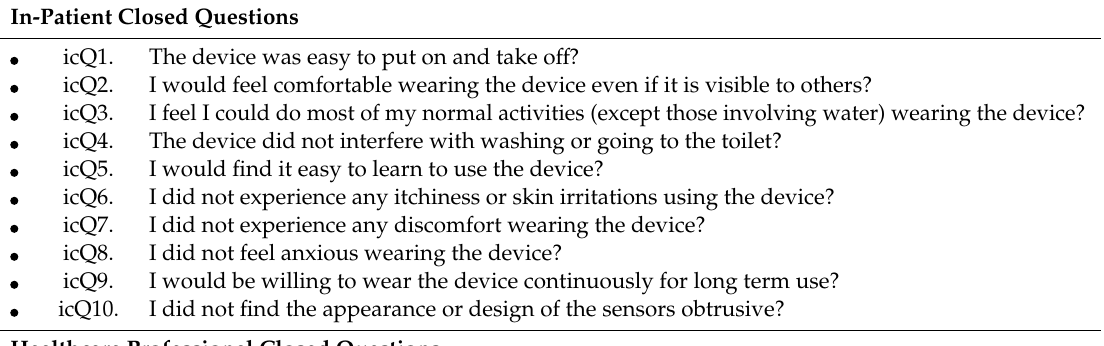
Table 1. Healthcare Professional and in-patient